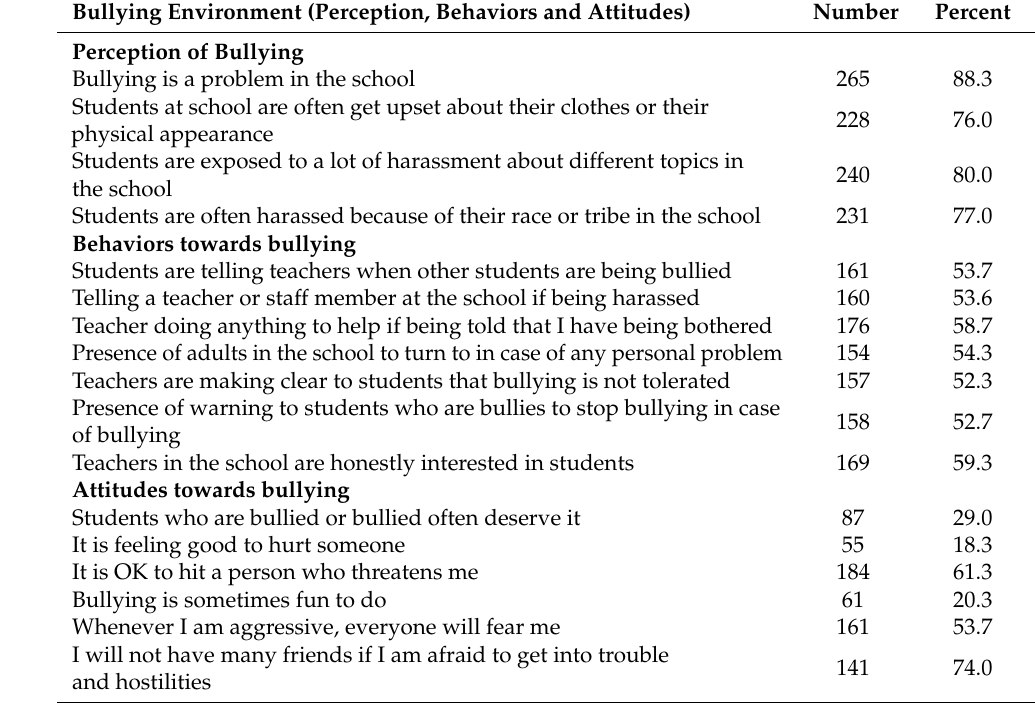
Table 3. Bullying environment (perception, behaviors, and attitudes) among secondary school students in Khamis Mushait city, southwestern Saudi Arabia ( n =